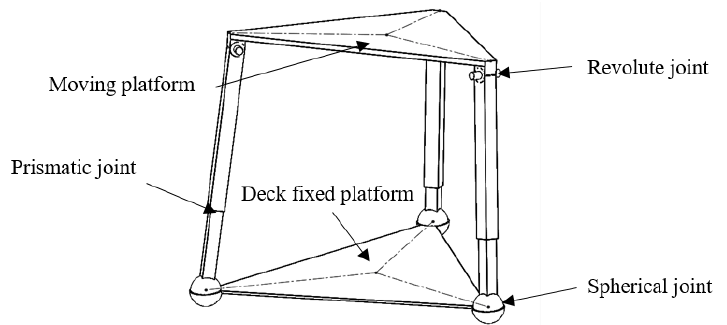
Figure 6. 3-SPR parallel compensation platform.